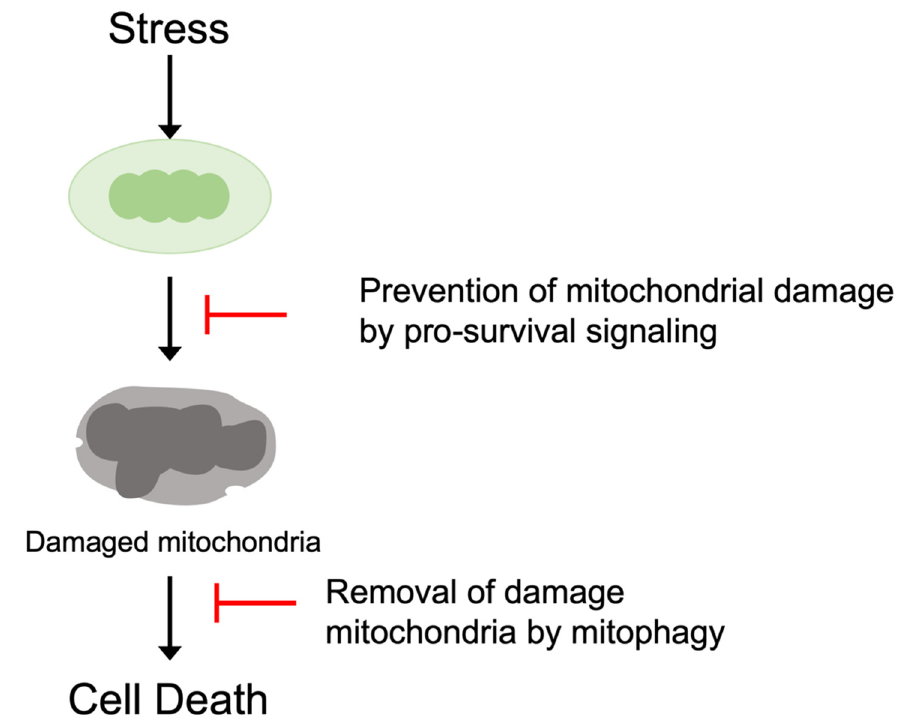
Figure 1. Prevention of the mitochondrial death pathway. Pro-survival signaling pathways antagonize the induction of the mitochondrial death pathway. Damaged mitochondria are also eliminated by mitophagy to preserve mitochondrial integrity and inhibit cell death.